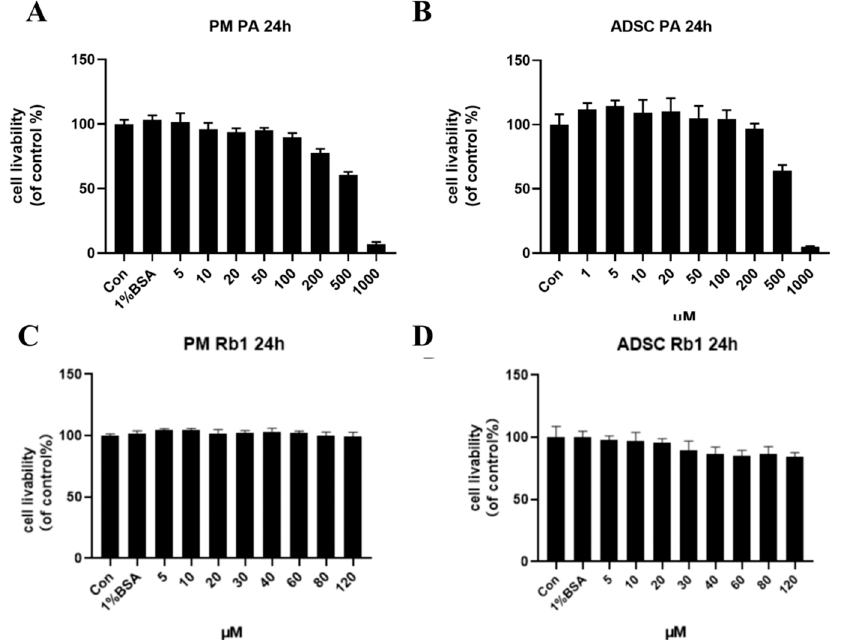
Figure 3. E ff ects of PA at di ff erent concentrations for 24 h on the cell livability of PM ( A ) and ADSC ( B ) cells; e ff ects of Rb1 at di ff erent concentrations for 24 h on the cell livability of PM ( C ) and ADSC ( D ) cells.